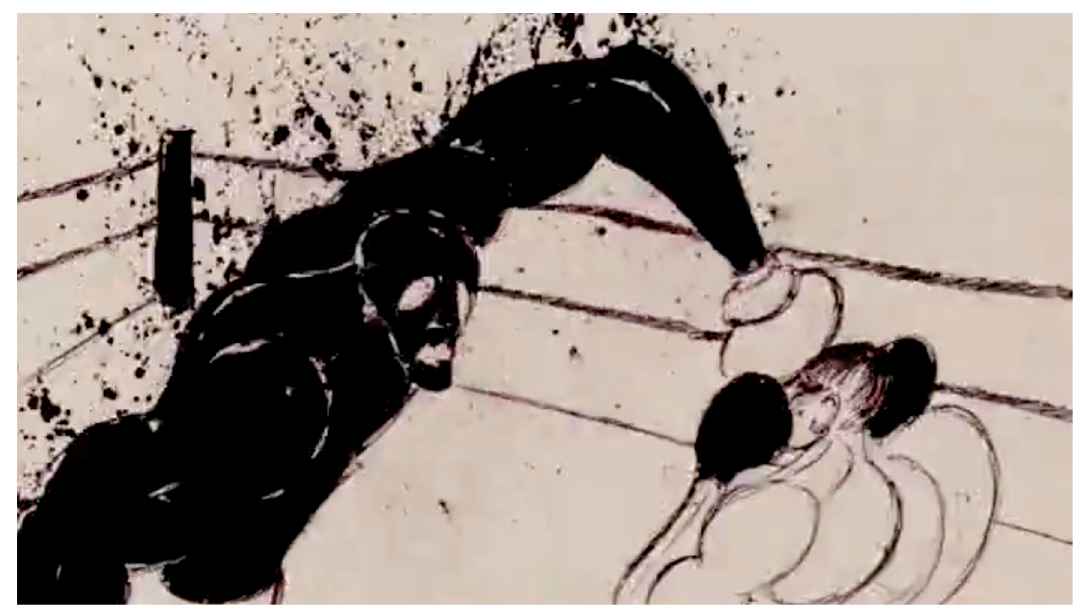
Figure 3. Bodies melt into ink. Frame capture, The Pride of Strathmoor (Baldvin 2014).